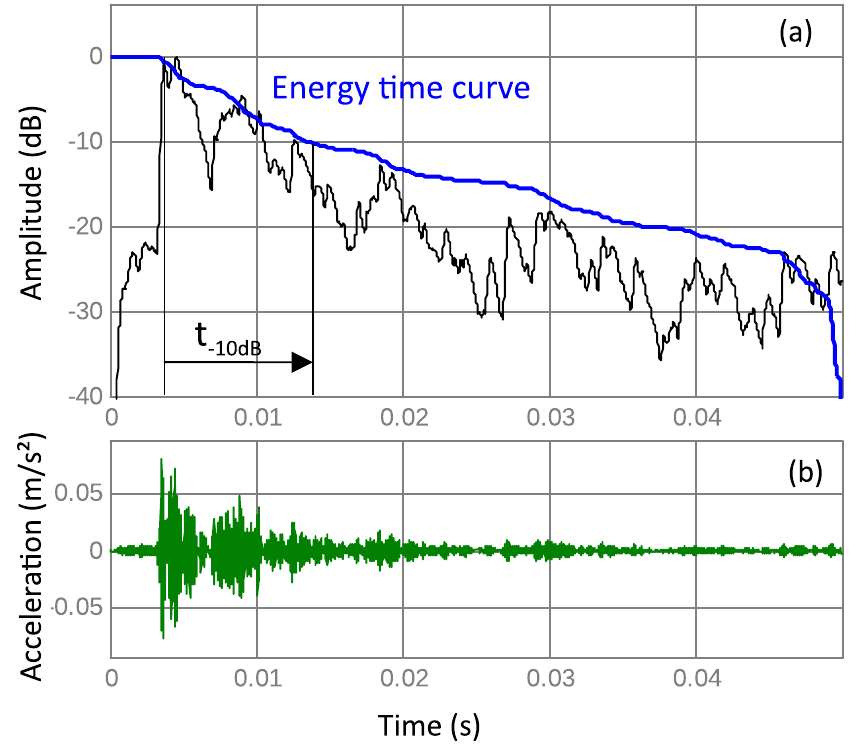
Figure 16. ( a ) Example of Schroeder integration and energy time curve calculations (blue curve) ( b ) Corresponding impulsive time